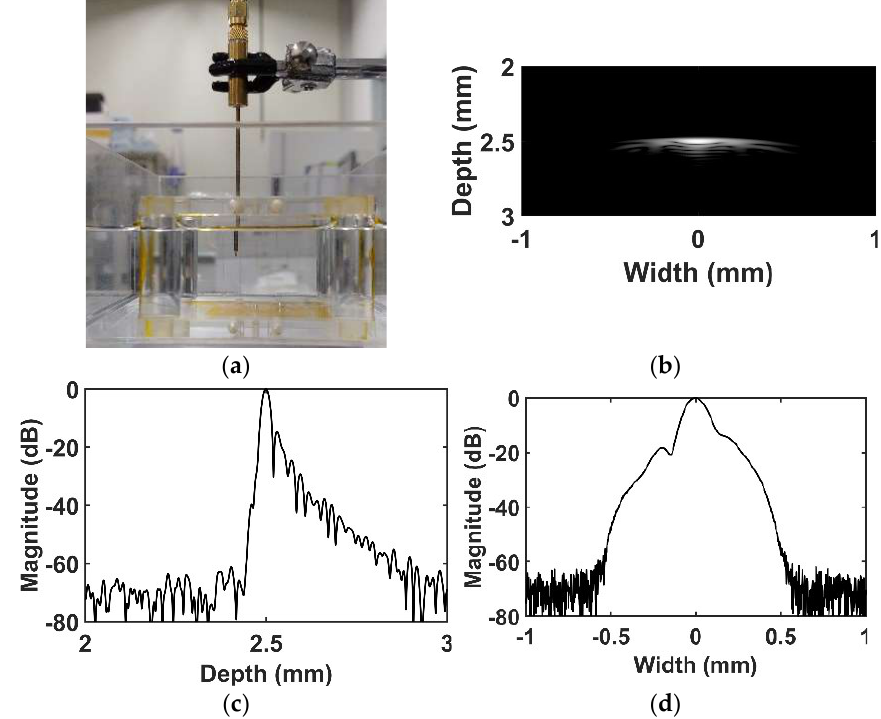
Figure 10. Experimental setup and B-mode image about the point spread function of a wire phantom by using the proposed IVUS transducer: ( a ) Experimental setup; ( b ) B-mode image; ( c ) axial beam pattern; and ( d ) lateral beam pattern.